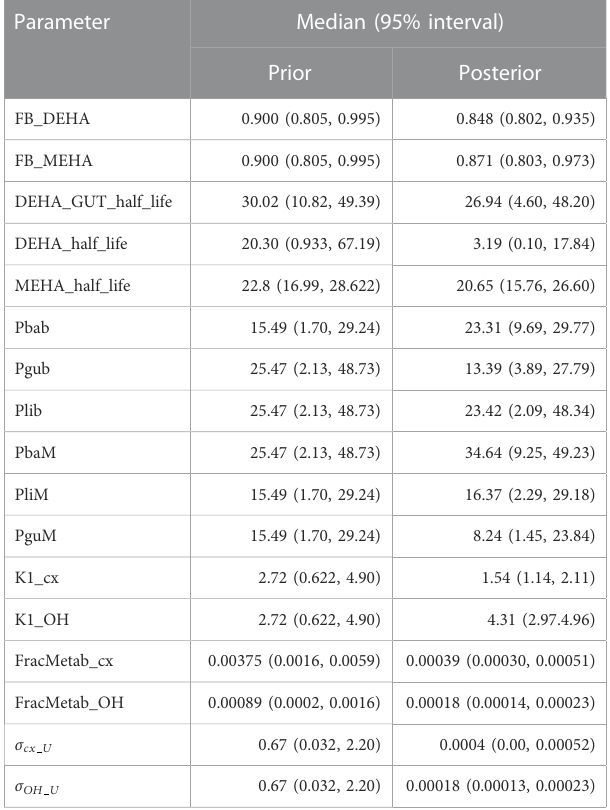
TABLE 4 Global prior and posterior distributions. Parameter Median (95% interval) Prior